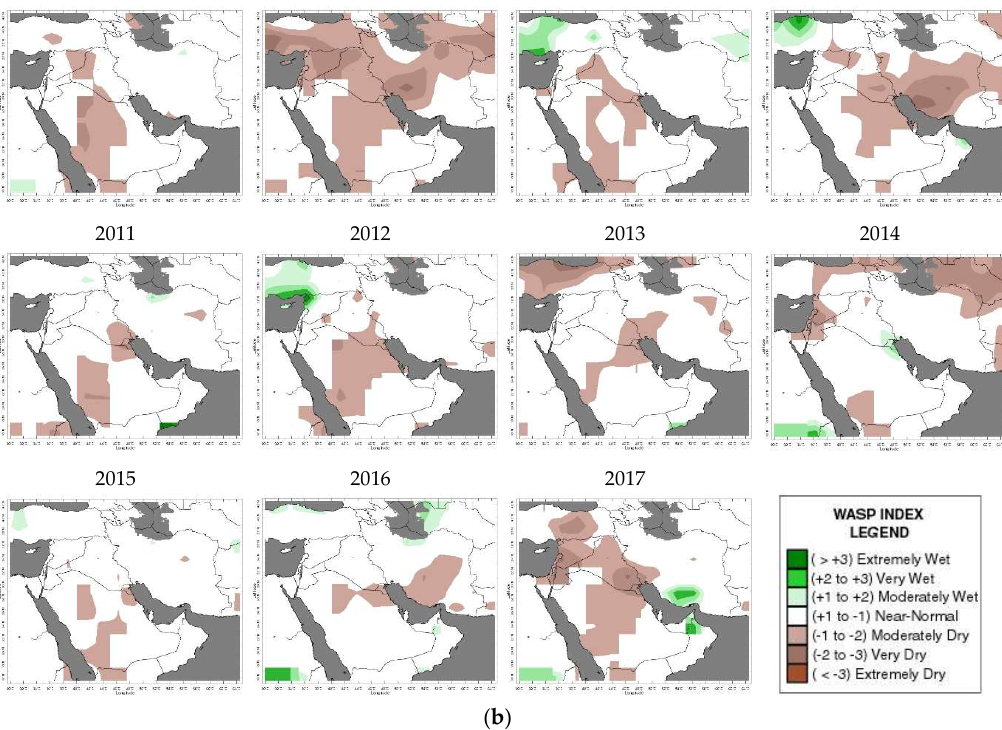
Figure 2. ( a ) Weighted Anomaly Standardized Precipitation (WASP) Index for selected countries of the Middle East 1979–1998; ( b ) WASP Index for selected countries of the Middle East 1999–2017